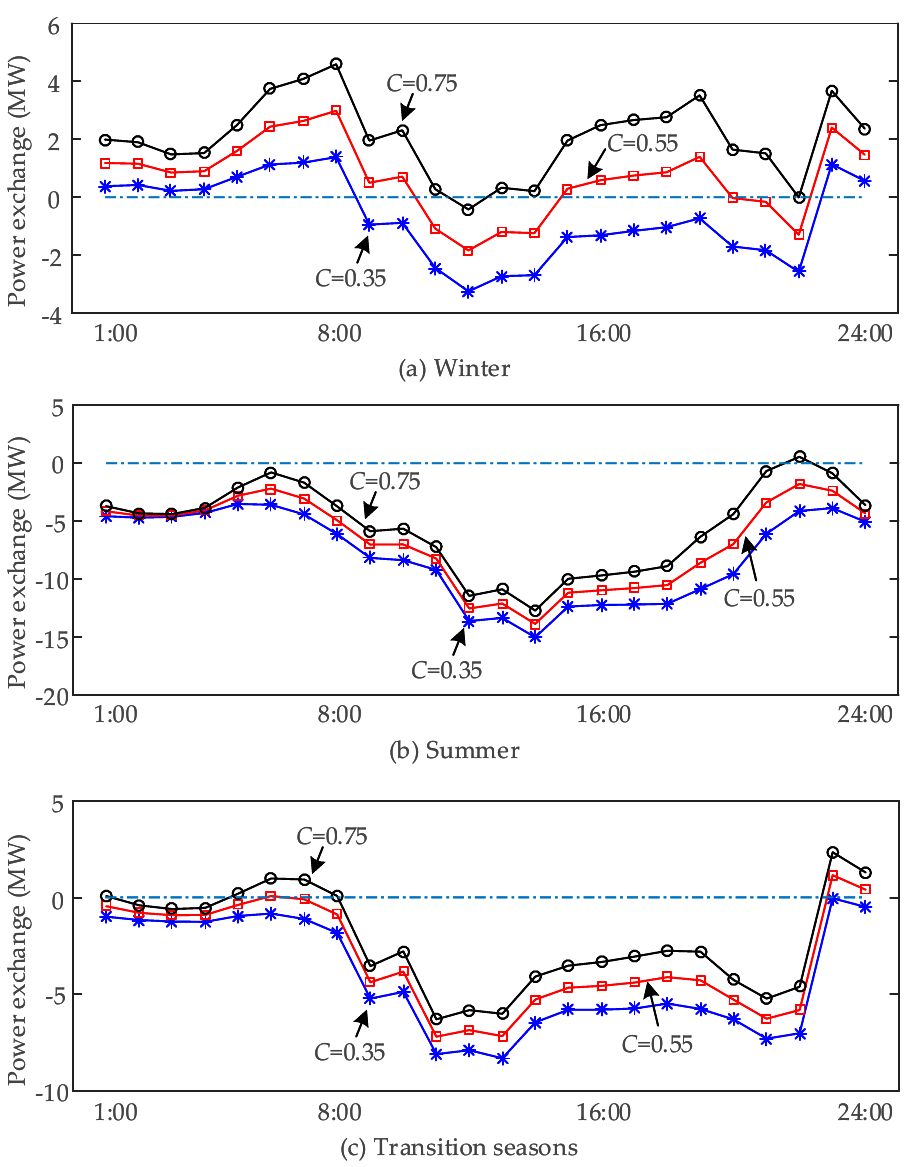
Figure 6. Power exchanges between CHP generation and power networks.